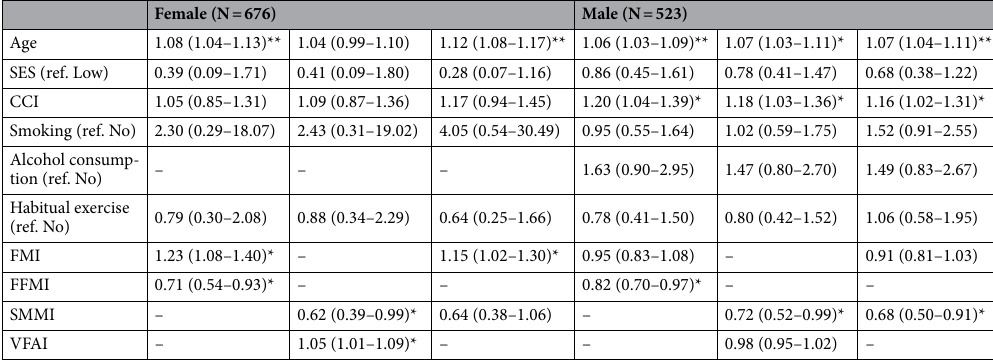
Table 6. Cox proportional hazard model analysis of the associations between the FMI, FFMI, SMMI, VFAI, and all-cause mortality by gender. Data was represented as: HR (95%CI). SES: socioeconomic status; CCI: Charlson comorbidity index; FMI: fat mass index. FFMI: fat free mass index; SMMI: skeletal muscle mass index, and VFAI: visceral fat area index. * p < .05; ** p <